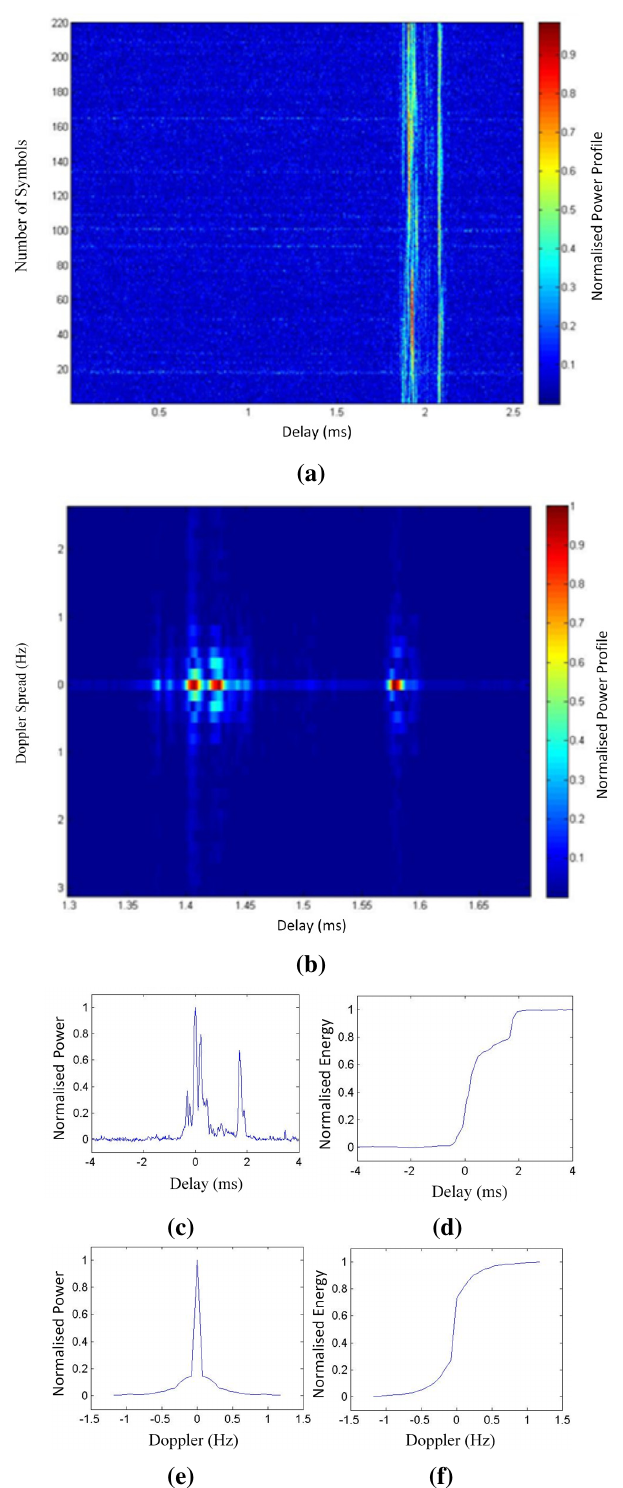
Figure 14. Wideband channel response and measures for 1 February 2014 at 07 UTC with 13 MHz of carrier frequency: ( a ) normalized channel response h [ n, τ ] ; ( b ) normalized [ τ , v ] ; ( c ) multipath power profile (in ms); ( d ) the integral of the scattering function R s multipath power profile to calculate the delay spread (in ms); ( e ) Doppler power profile (in Hz); and ( f ) the integral of the Doppler power profile to calculate the Doppler spread (in